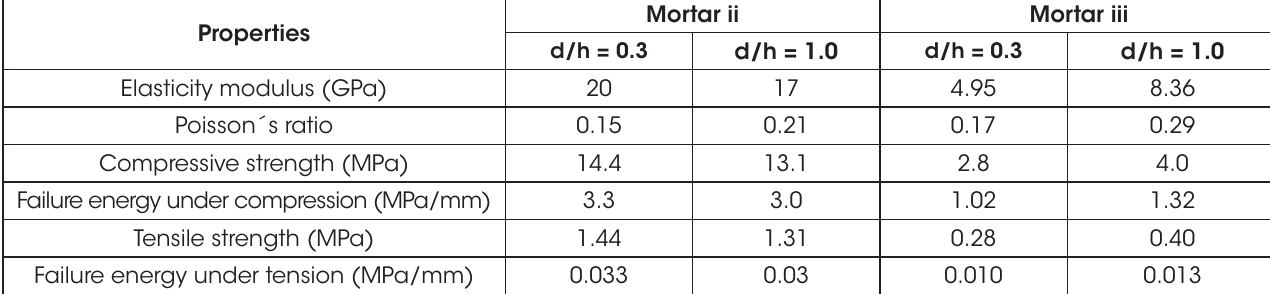
Mechanical properties of the mortar